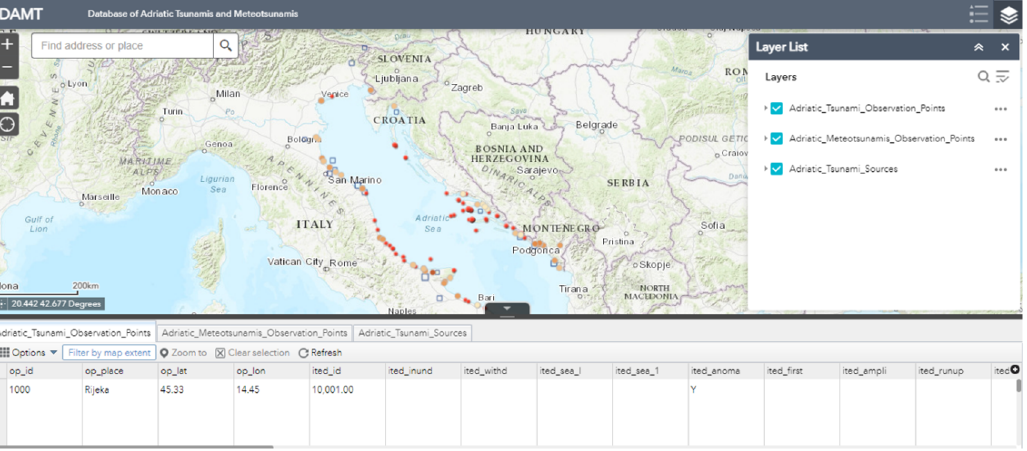
Figure 2. The attribute table allows the user to filter the data contained in the layers of the WebApp according to different selections.